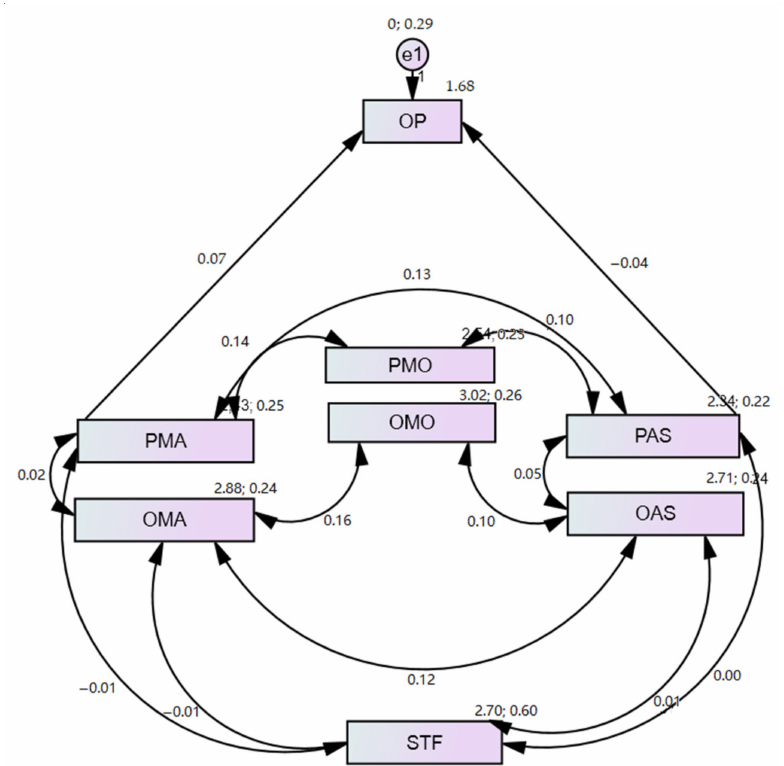
Figure 1. Estimates of the structural equation model. Note: OP = Opinion; STF = Satisfaction; PMO = Perception Modalities; OMO = Opinion Modalities; PMA = Perception Methodological Ap- proaches; OMA = Opinion Methodological Approaches; PAS = Perception Assessment Systems; OAS = Opinion Assessment